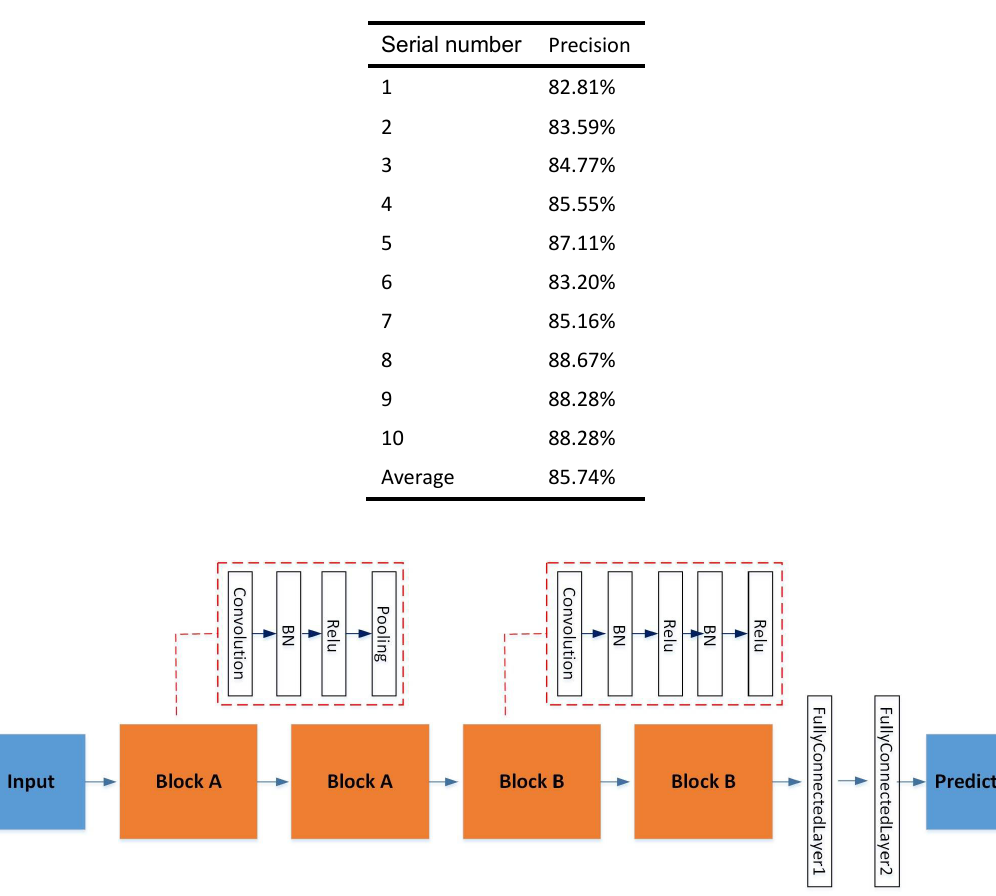
Table 3 Statistical result (using dropout)